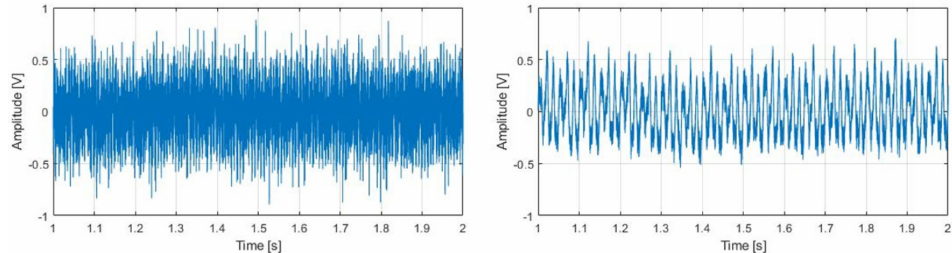
Figure 5. Signal from microphone no.1 introduced in the signal separation algorithm ( left ) and the machining signal resulting from the signal separation of the 4 microphones ( right